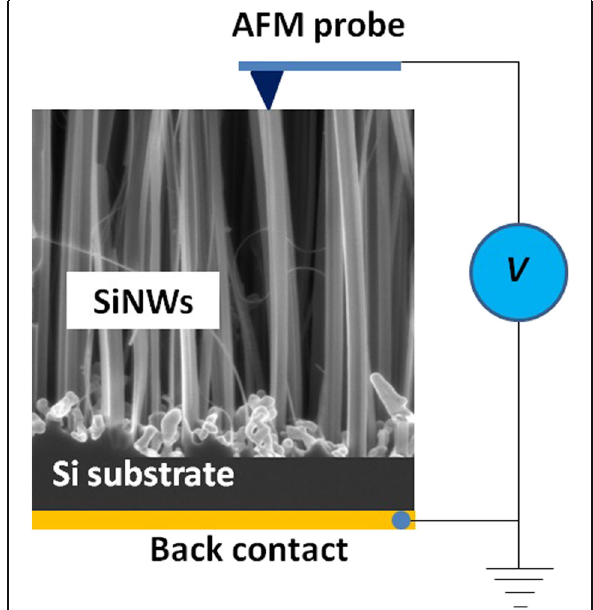
Fig. 8 Schematic diagram of the experimental setup for the electrical measurement by AFM